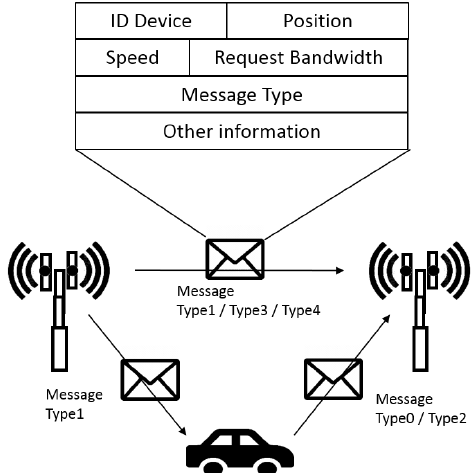
Figure 2. Message format exchanged among devices.